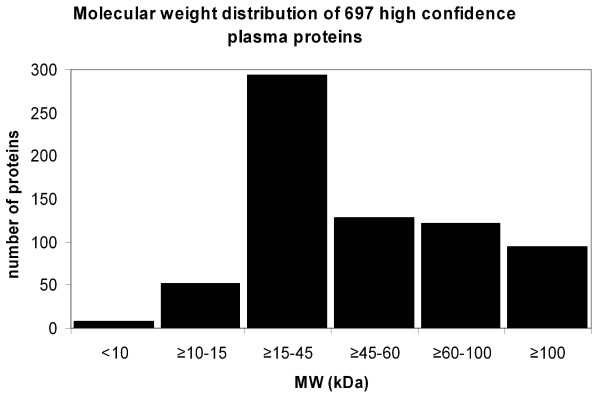
Histogram showing the molecular weight distribution of the calculated masses of 697 observed plasma proteins. The calculated protein masses for all proteins from all experiments were categorized into molecular weight groups as indicated so that the number of proteins falling into each molecular weight group is proportional to the height of each bar in the histogram.